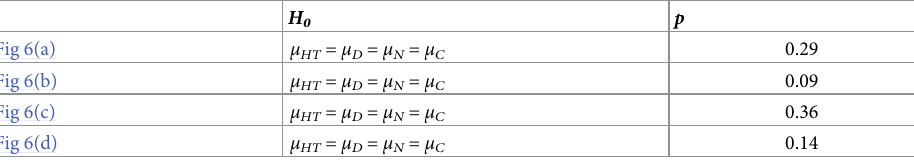
Table 2. P-values and null hypotheses relating to Fig